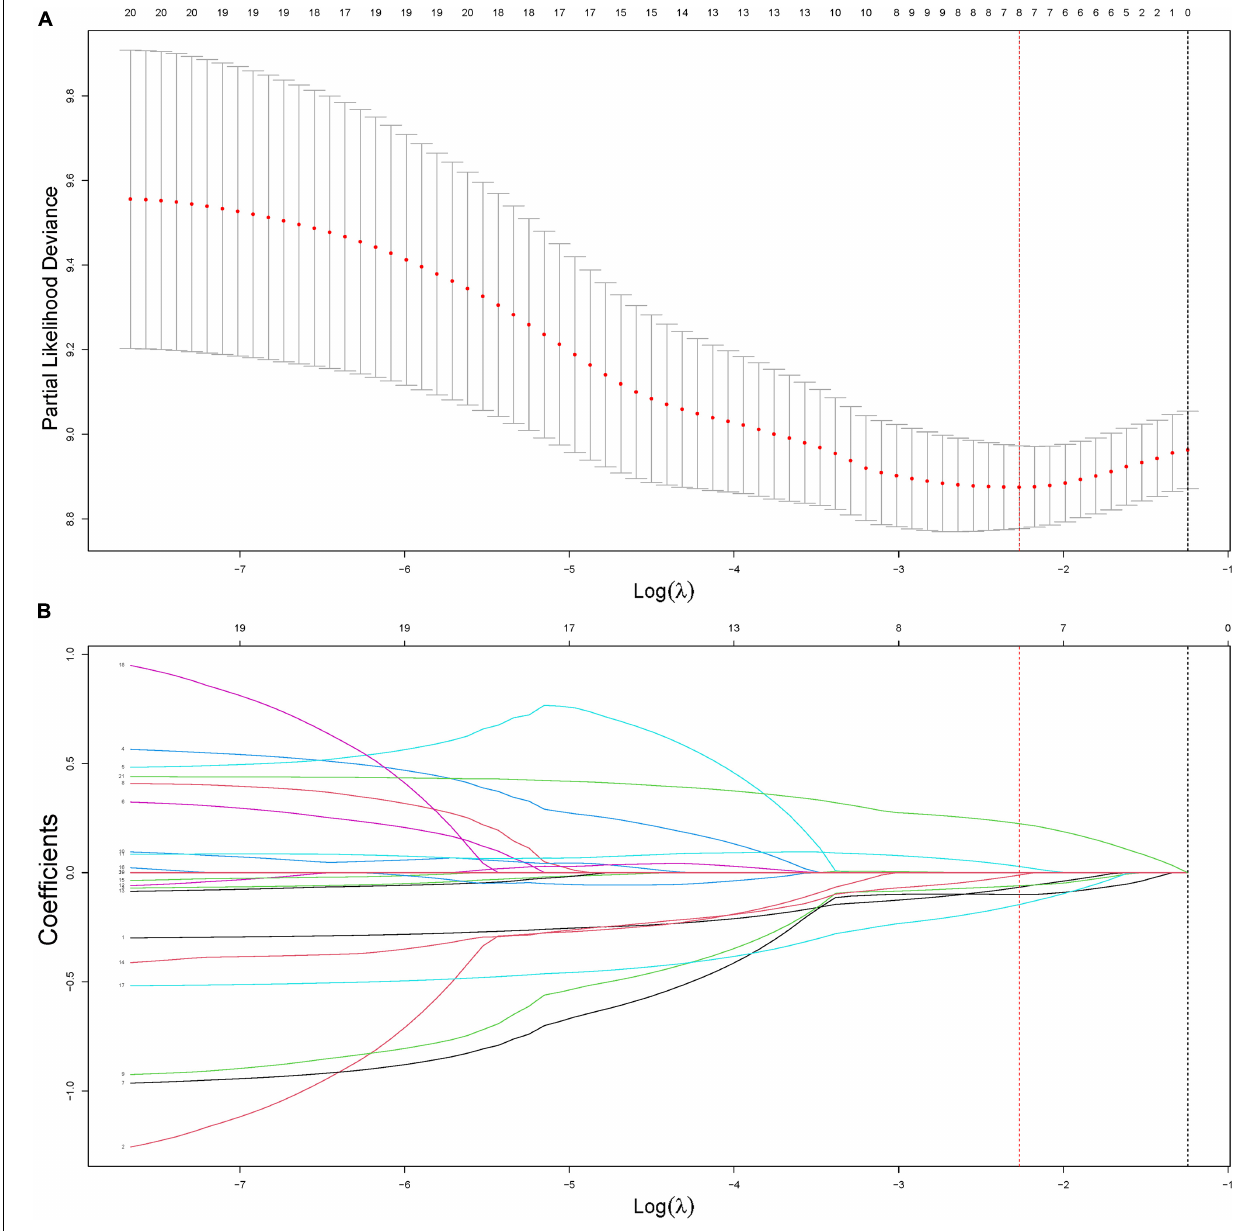
FIGURE 3 | Construction of the radiomics signature using least absolute shrinkage and selection operator (LASSO) Cox regression. (A) An optimal tuning parameter ( λ ) in the LASSO regression model was selected using fivefold cross-validation and the partial likelihood deviance rule. Two vertical dashed lines were drawn for two criteria: (1) the minimum of the partial likelihood deviance (lambda.min, red dashed ) and the least feature number in the range of 1 standard error around lambda.min (lambda.1SE, black dashed ). In this study, lambda.min (0.1035244) was selected to minimize the partial likelihood deviance. (B) LASSO coefficient profiles of the features. According to the fivefold cross-validation in panel (A) , the optimal λ value was determined at lambda.min, and the corresponding features with non-zero coefficients were included in the construction of the radiomics